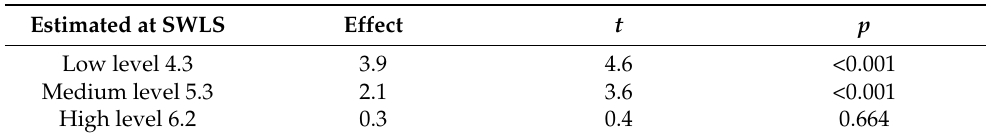
Table 4. Regression analysis for testing the moderating effect of satisfaction with life on group dif- ferences in postnatal depressive symptomatology.